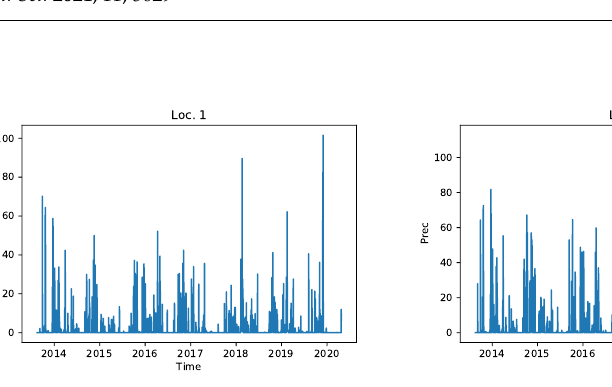
Figure 1. Precipitation amount for each site.